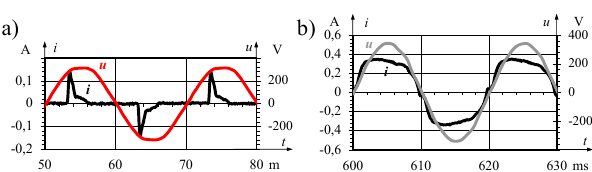
Fig.5. Steady-state current waveform for: a) PHILIPS FILAMENT LED bulb for household use: 4 W; E27; b) POLARIS PLUM-46-D road